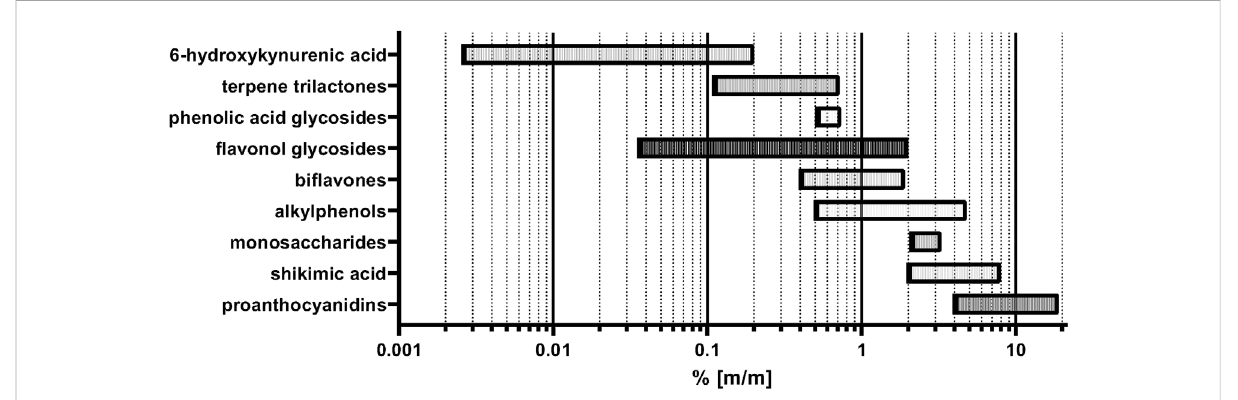
FIGURE 1 Summary of minimum and maximum concentrations of constituents in G. biloba leaves according to literature and in cases of the fl avonol glycosides and PACs own data on upper